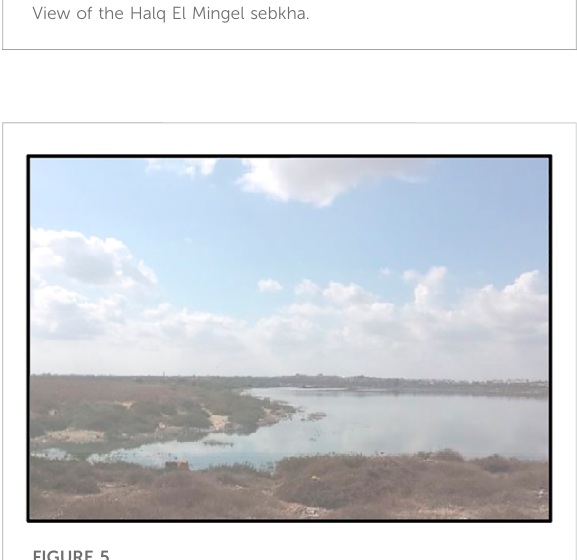
FIGURE 5 View of the Sousse-sebkha